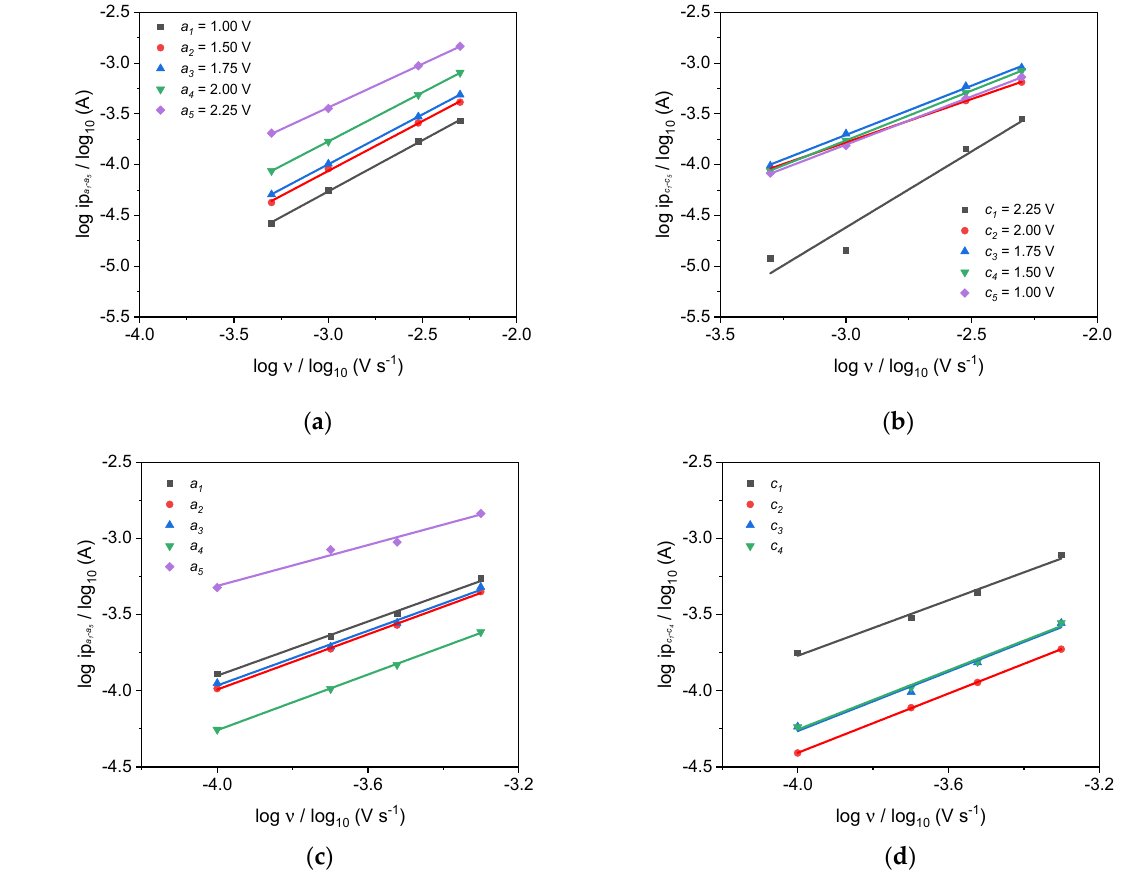
Figure A3. Determination of b-values in CXG 500 ||Al at the anodic ( a ) and cathodic ( b ) CV scan and for natural graphite for intercalation peaks a 1–5 ( c ) and deintercalation peaks c 1–4 ( d ).